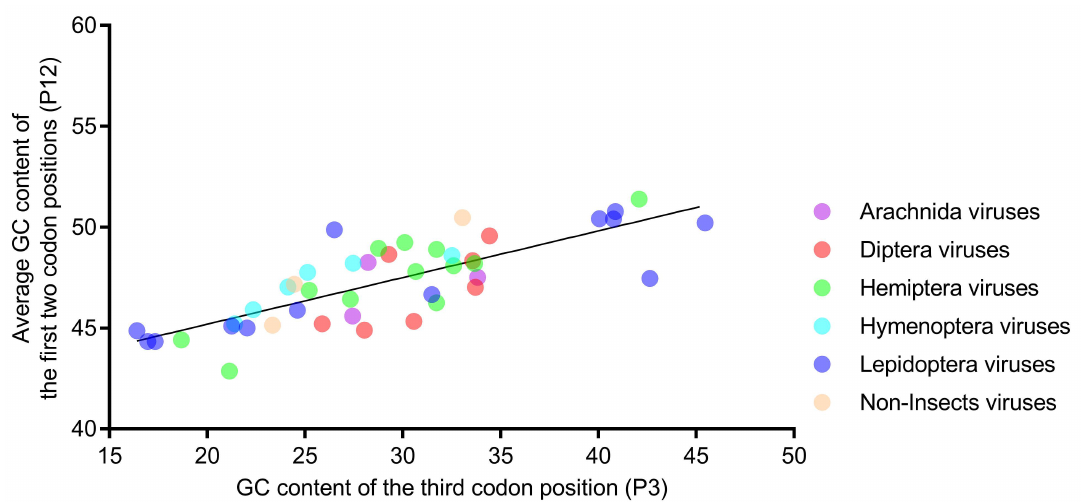
Figure 5. The regression slope of P 12 (average of P 1 and P 2 ) against P 3 was found to be low in the relative neutrality analysis, indicating that selection dominates mutations in shaping the nucleotide composition. Members of the six host-taxa-groups were all interspersed around the regression line, implying that the factors a ff ecting the codon usage of di ff erent host-taxa-groups are similar. Each dot represents a viral genome corresponding to the two coordinate axes. The solid line indicates the regression, with equation Y = 0.231X + 40.57, R 2 = 0.615, and p <